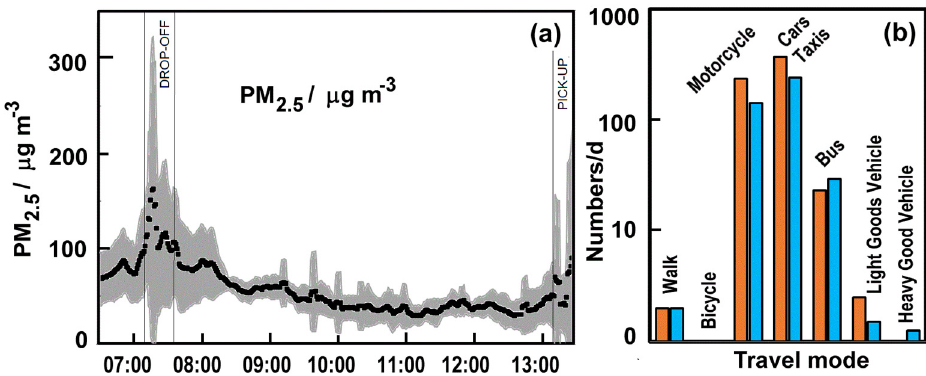
Figure 2. ( a ) Four-day averaged PM 2.5 concentration at a school drop-off zone smoothed with a five-point moving average with the standard deviation bound by the shaded area with local times on x -axis. ( b ) Student travel mode counts for 06:30/08:00 (orange) and 12:30/13:30 (blue) averaged for two schools.